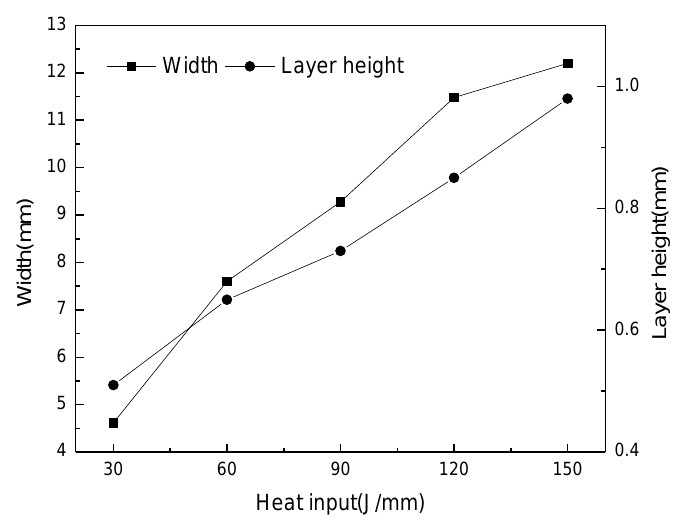
Figure 2. The thickness and layer height of the deposits change with the heat input.